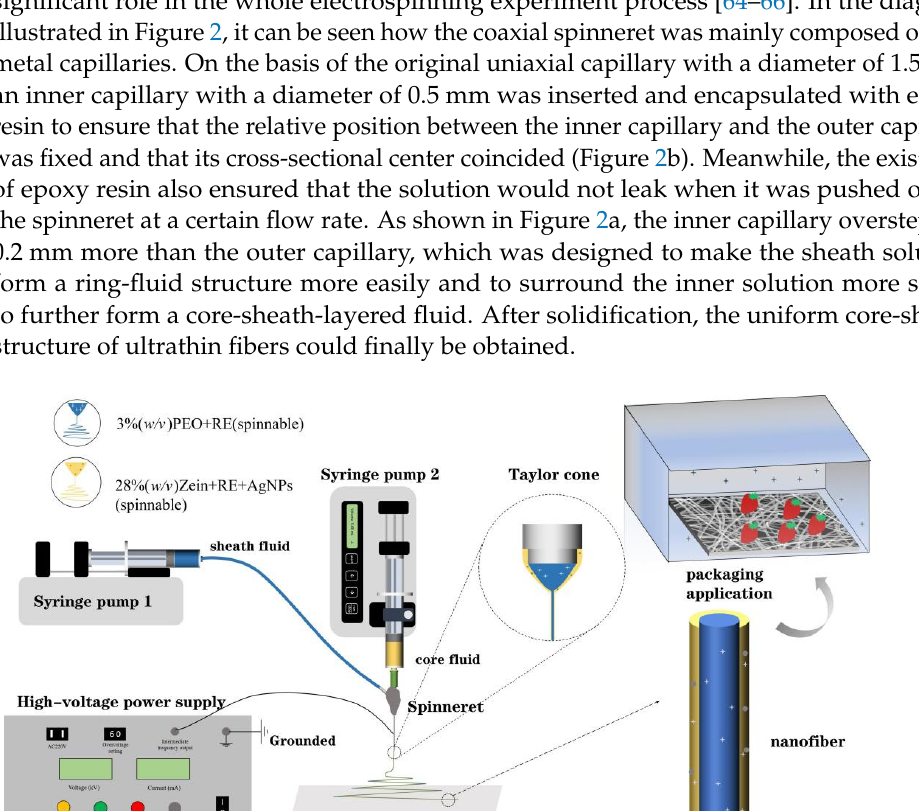
Figure 2 . Structure of homemade coaxial spinneret: ( a ) diagram of designed detail structure of the coaxial spinneret; ( b ) coaxial spinneret and the head of the spinneret (bottom-left insert). In the whole electrospinning process, the positive and negative poles of the high- voltage power supply were connected to the spinneret capillary and aluminum foil, re- spectively, which led to the formation of a high-voltage electrostatic field between the spinneret and aluminum foil [67–69]. As shown in Figure 1, the purpose of grounding was to introduce the charge on the aluminum foil into the ground and ensure a safer experi- mental environment. Driven by the syringe pump, the droplet of polymer solution was dropped down to the tip of spinneret at a certain flow rate, and was stretched into a Taylor cone under the effect of the high-voltage electrostatic force emitting a micro/nanojet. The jet would go through the whipping and bending process due to the electrostatic field force, reach the aluminum foil and transform into ultrathin fibers while rapid drying [70,71]. At the same time, during this process, the active substances uniformly dispersed in the solution would also maintain their morphology due to a high degree of solid dis- persion that exists in ultrathin fibers [71,72]. In previous studies, it was concluded that only one fluid should be electrospinnable in coaxial electrospinning as the electrospinna- bility of the other fluid was not necessary, which was called modified coaxial electrospin- ning [73,74]. In this study, this theory was reflected. Despite the poor spinnability of zein in single electrospinning, the PEO fluid played a leading role in having strong spinnability to drive zein to form a continuous sheath structure of fibers around itself. 3.2. Morphology and Structure of Core-Sheath Ultrathin Fibers The SEM images of uniaxial ultrathin fibers and coaxial ultrathin fibers are shown in Figure 3. Figure 3a refers to PEO single-fluid electrospinning fibers, and Figure 3b refers